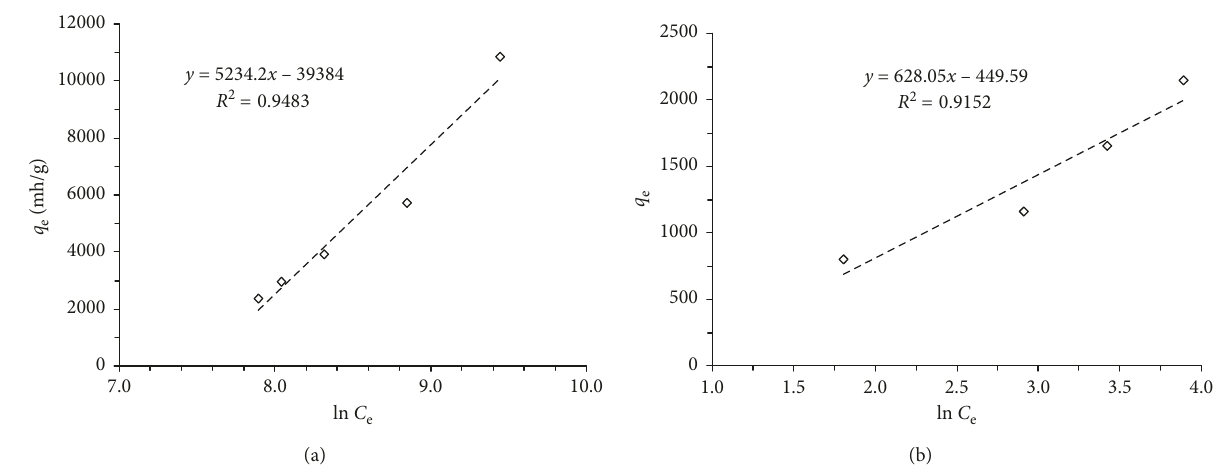
Figure 9: Temkin isotherm plot using modified bagasse under (a) laboratory and (b) pilot scales.